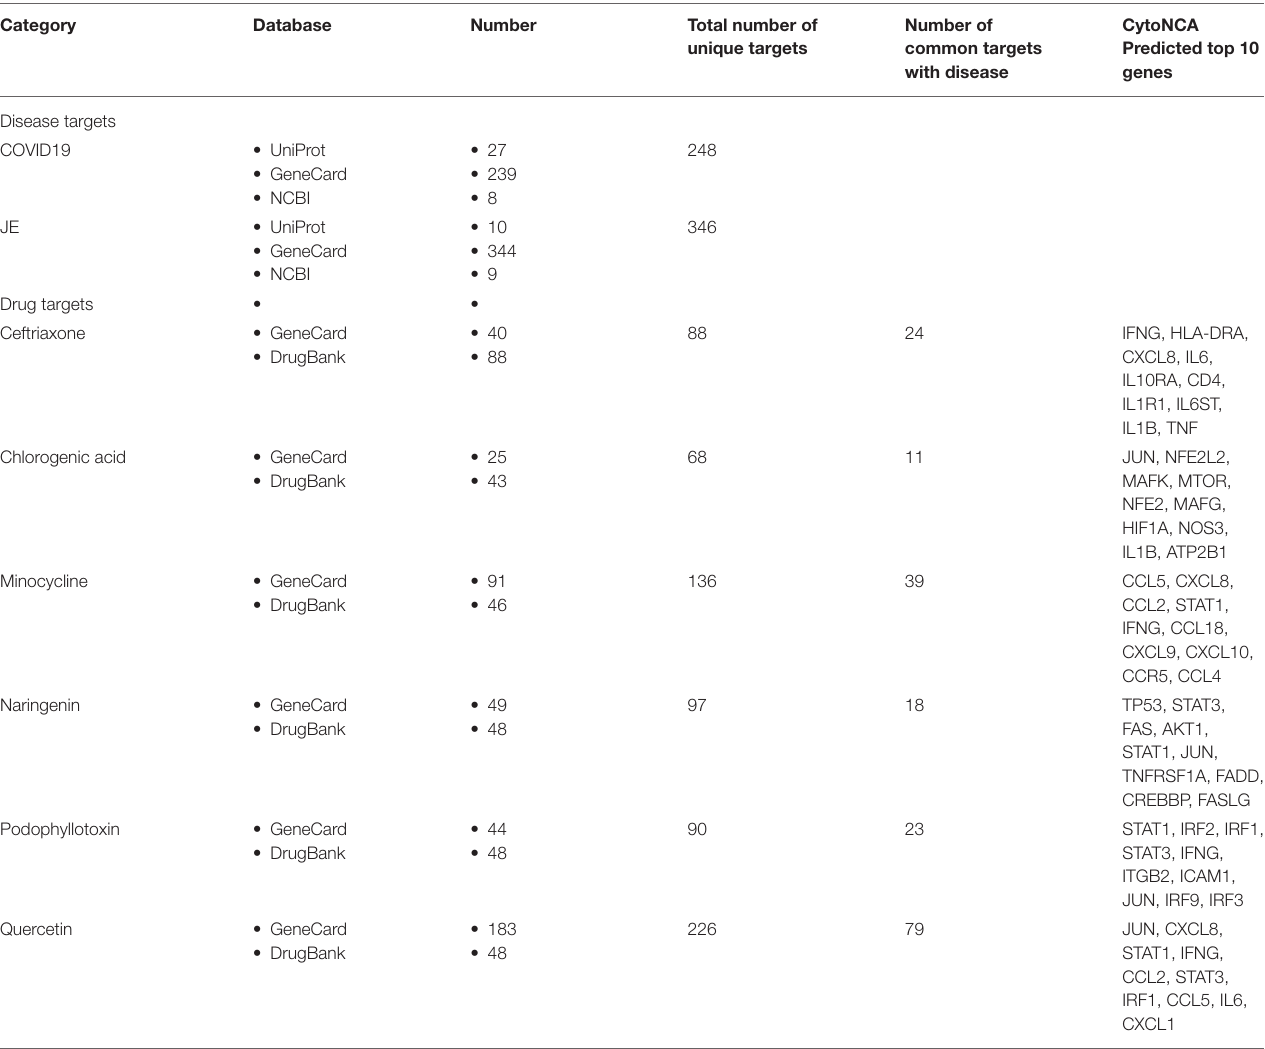
TABLE 1 | Total number of retrieved targets from different